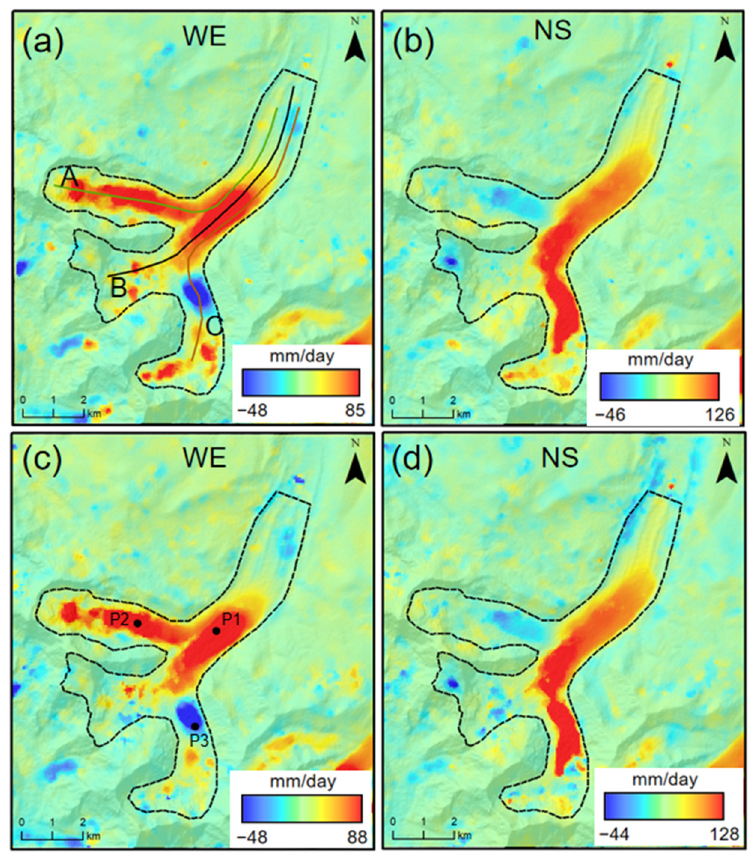
Figure 7. Two-dimensional deformation rates of glaciers before and after fusion in the study area: ( a ) west–east deformation rate after fusion; ( b ) north–south deformation rate after fusion; ( c ) optical east–west deformation rate before fusion; ( d ) optical north–south deformation rate before fusion.